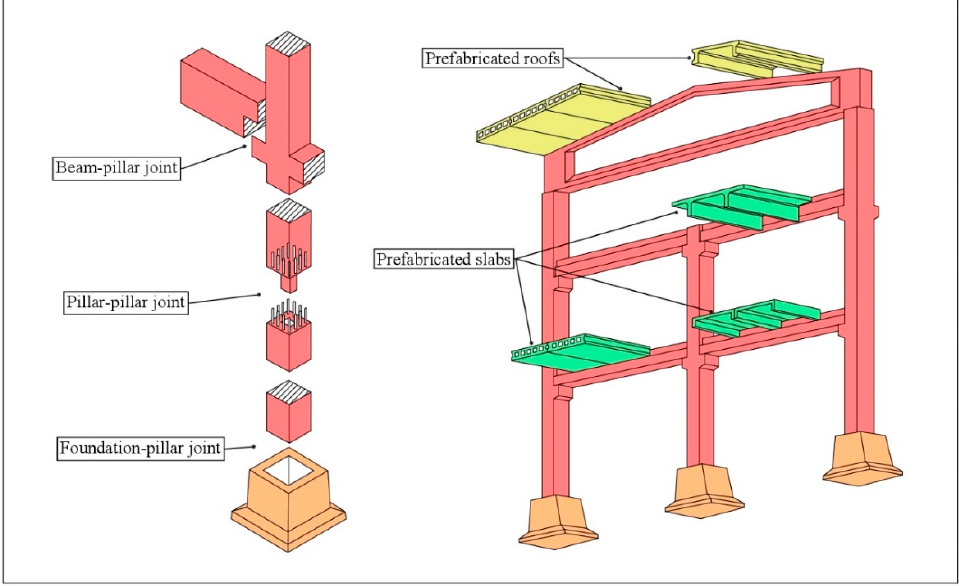
Figure 7. Buildings made of prefabricated components scheme (drawing by G.B.).